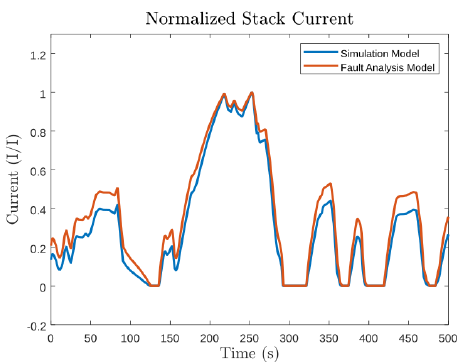
Figure 2. Comparison of normalized stack current between simulation model and fault analysis model.